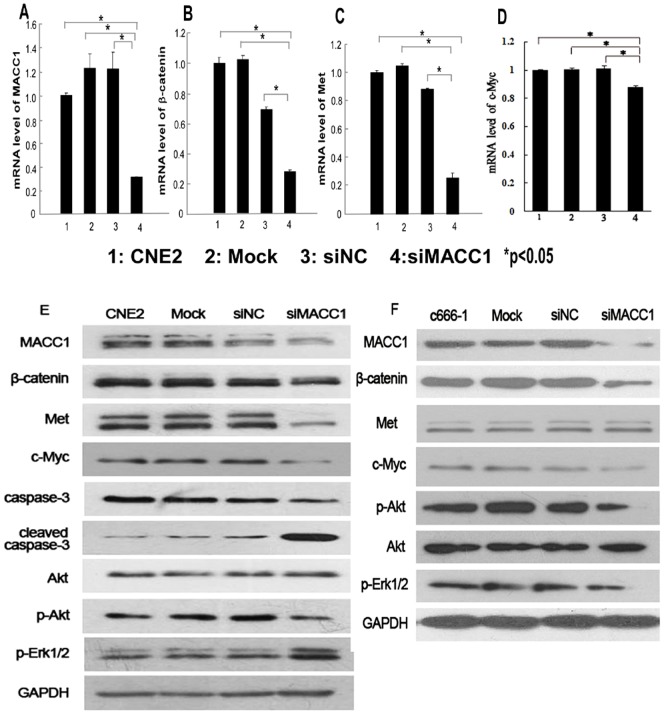
MACC1 down-regulation significantly reduced MACC1, β-catenin, Met, and c-Myc mRNA expression in CNE2 transfected with MACC1 siRNA for 48h by real-time PCR analysis, compared with the control group(A, B, C, D), *p<0.05.At the protein level, MACC1 knockdown resulted in inhibition of β-catenin, Met, and p-Akt (Ser473) protein expression, increased cleaved caspase-3, but no alteration on p-Erk1/2 in CNE2 cell line by western blot analysis (E); MACC1 knockdown resulted in inhibition of β-catenin and p-Akt (Ser473) protein expression, but no alteration on p-Erk1/2 in C666-1 cell line by western blot analysis (F).